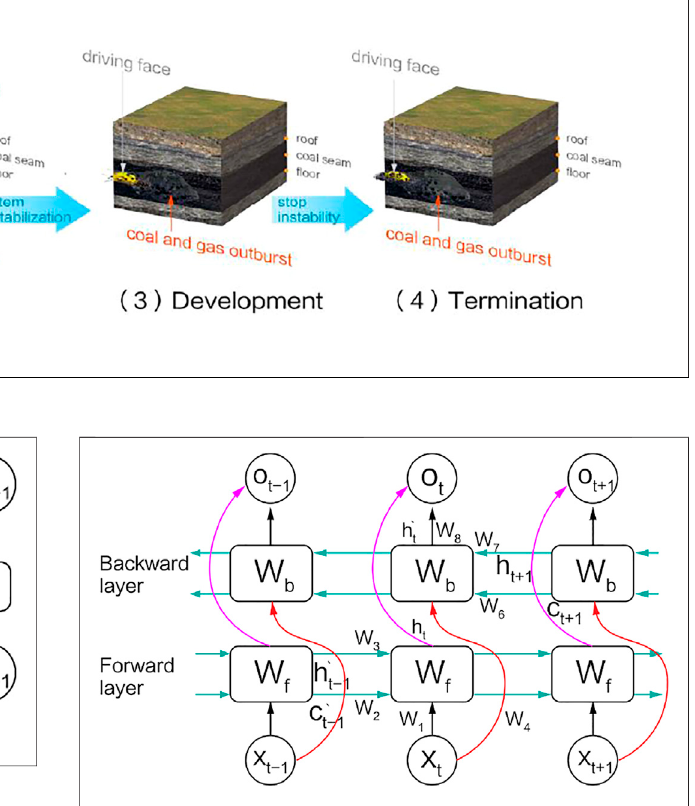
FIGURE 3 | Principle of bidirectional LSTM algorithm